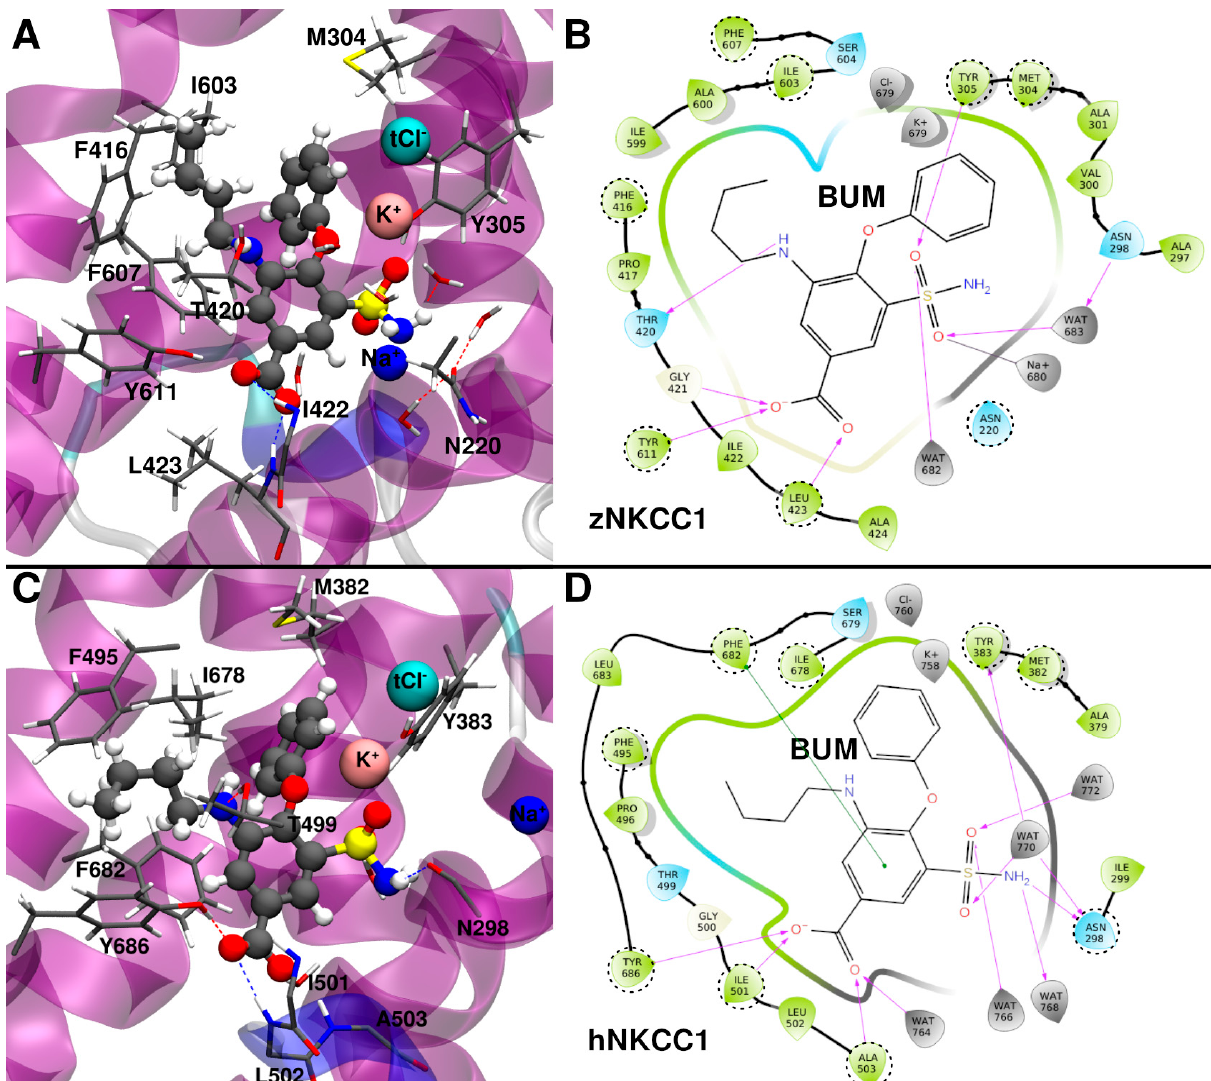
Figure 3. ( A ) Binding mode of bumetanide (BUM) to zebrafish (z)NKCC1 taken from a representative structure of the most populated cluster extracted from the molecular dynamics (MD) trajectory. ( B ) 2D schematic representation of the BUM/zNKCC1 interactions. ( C ) Binding mode of BUM to human (h)NKCC1 taken from a representative structure of the most populated cluster extracted from the MD trajectory. ( D ) 2D schematic representation of the BUM/hNKCC1 interactions. Polar/charged protein residues are colored blue, while the others are colored green. Waters and ions are colored gray. The most important protein residues, identified by alanine scanning analysis, are highlighted by dashed